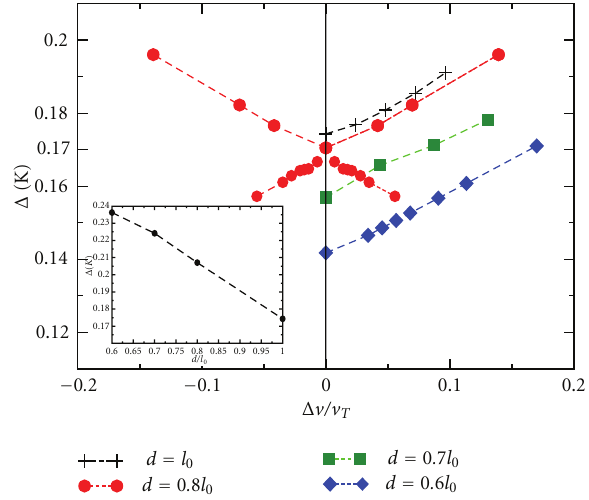
Figure 2: Expected activation energy Δ as a function of relative density imbalance between the layers, Δ ν / ν T . For voltage drop measured in the drive layer, the results are asymmetric with around Δ ν = 0, as shown explicitly for d = 0 . 8 (cid:2) 0 (see text). For measurements in the drag layer, the data is reflected around Δ ν = 0; the measured result would follow the higher of the two activation energies, yielding a result symmetric in bias. Inset: activation energy at zero bias versus layer separation. Reproduced from